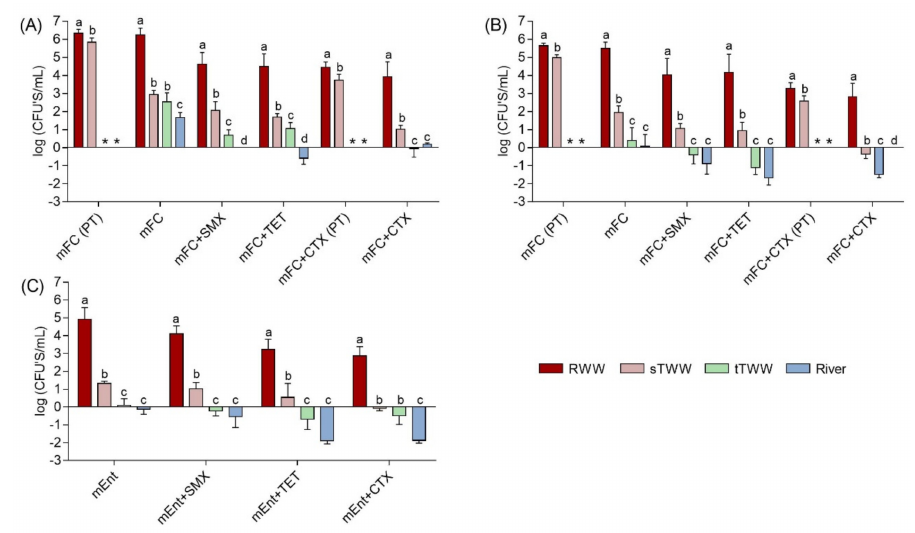
Figure 1. Colony forming units (CFUs) of ( A ) presumptive total coliforms, ( B ) presumptive fecal coliforms, and ( C ) presumptive enterococci expressed as log CFU / mL of sample. Bacteria were